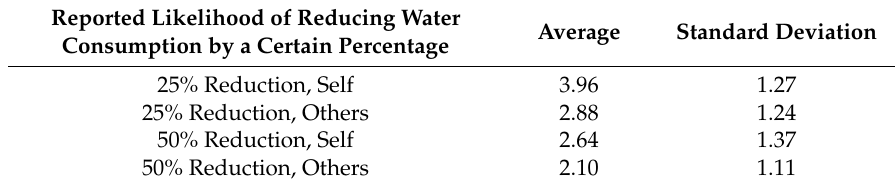
Table 4. Survey responses on reported likelihood of reducing water by a given percentage, self and others (1 = “Very Unlikely”, 3 = “Neither Likely nor Unlikely”, 5 = “Very Likely”). Reported Likelihood of Reducing Water Consumption by a Certain Percentage